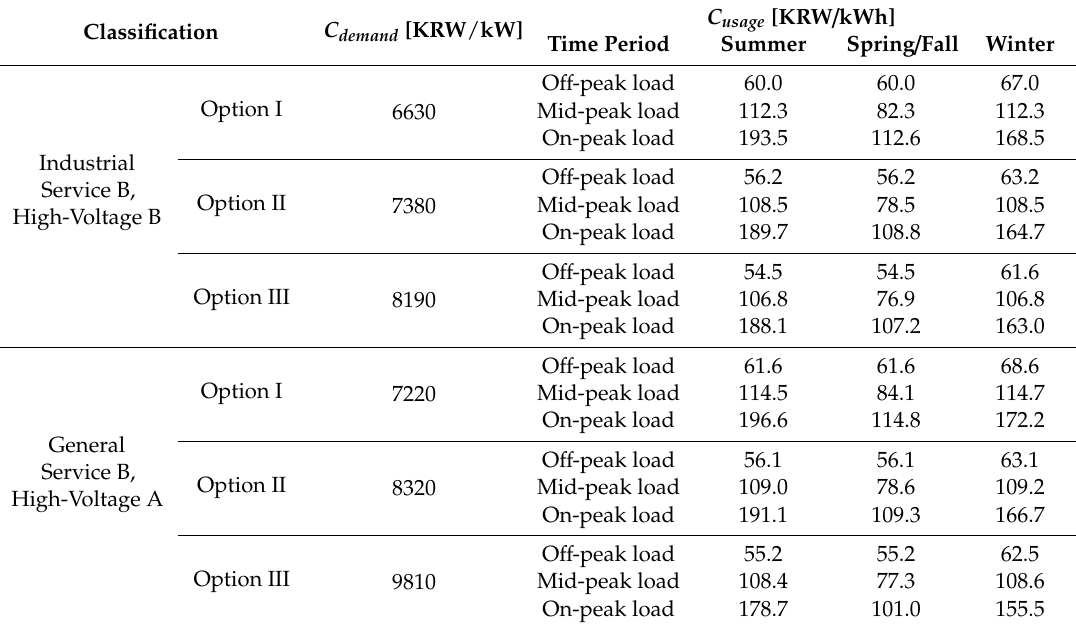
Table 2. Examples of a TOU tari ff